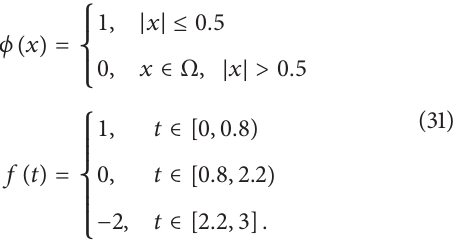
Figure 4: Numerical